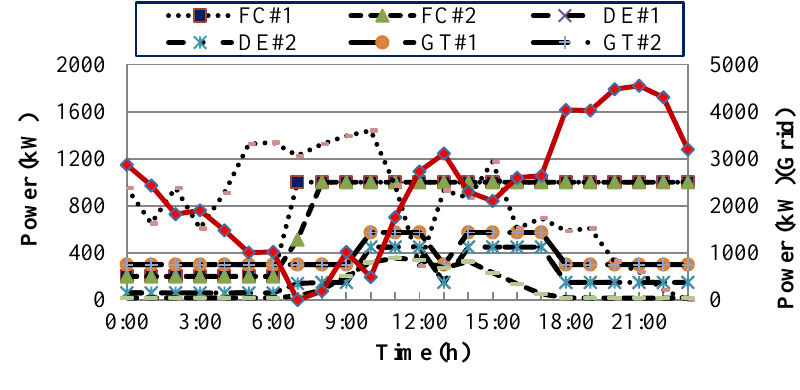
Figure 11. Numerical results for the optimal generation of each DG and utility power grid under grid-tied